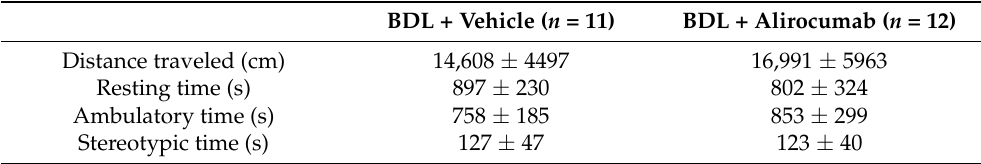
Table 3. Motor activities in BDL rats with or without alirocumab